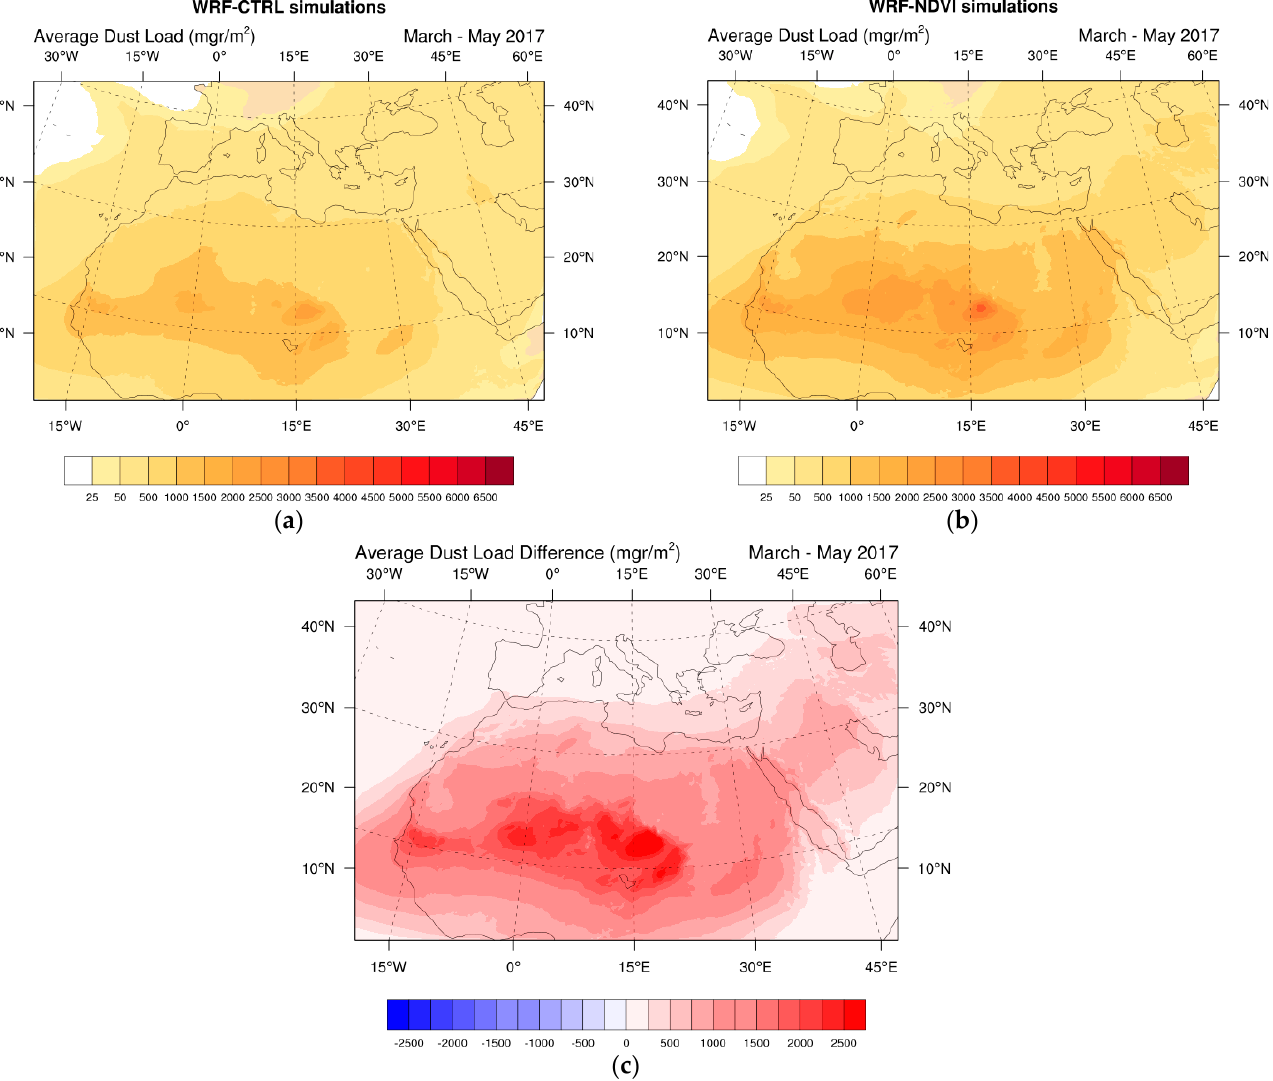
Figure 4. Average dust load in mgr/m 2 for ( a ) the WRF-CTRL simulations, ( b ) the WRF-NDVI simulations and ( c ) their difference.